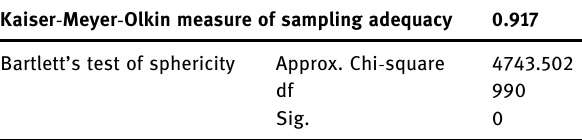
Table 6: KMO and Bartlett ’ s tests for the study delay